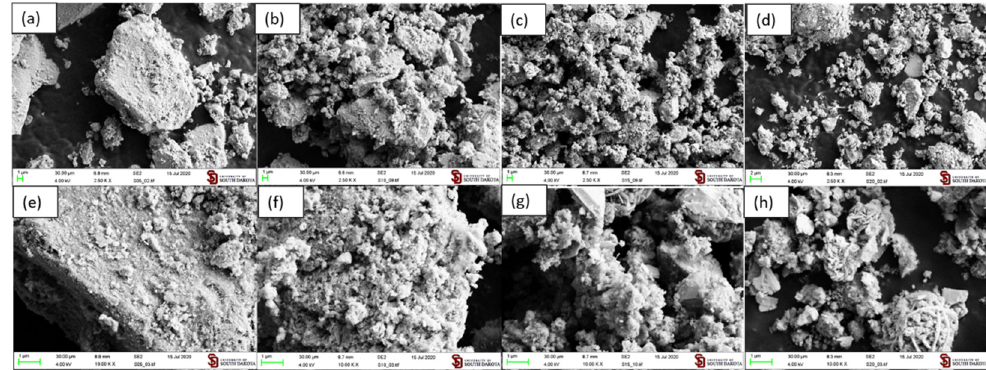
Figure 3. SEM images for X wt. % of SnS 2 /TiO 2 : (a–e) ST-5, (b–f) ST-10, (c–g) ST-15, and (d–h) ST-20